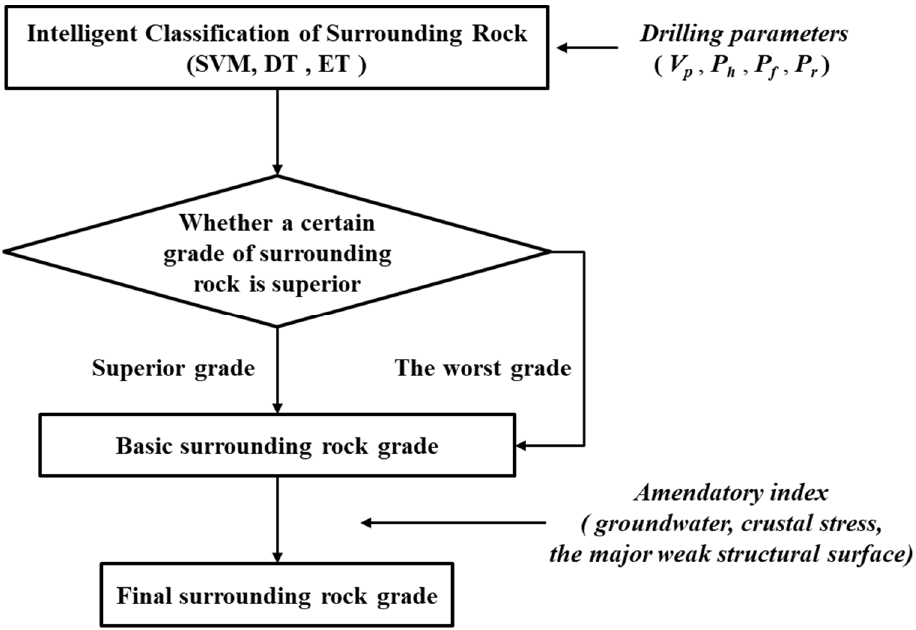
Figure 10. Classification process of the intelligent surrounding rock classification system. The system interface is shown in Figure 11.